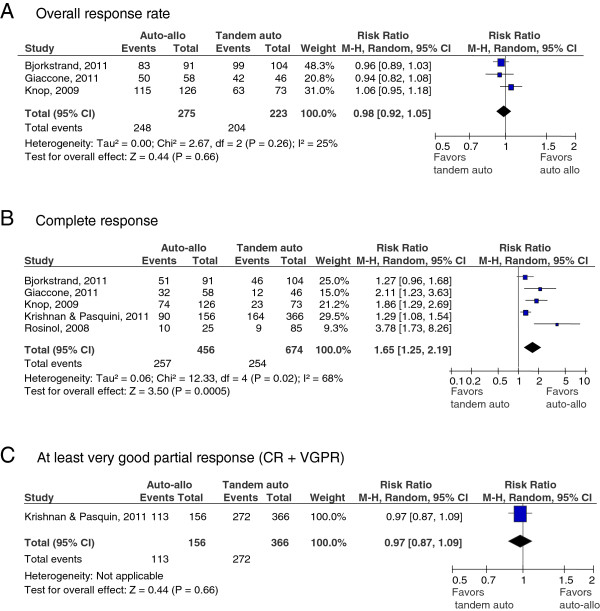
A through 2C: Forest plot for response rates. Overall (A), complete (B) or at least very good partial response (C). The summary estimate (risk ratio) from individual studies is indicated by rectangles with lines representing the 95% confidence intervals (CIs). The summary pooled estimate from all studies is represented by the diamond and the stretch of the diamond indicates the corresponding 95% CI.